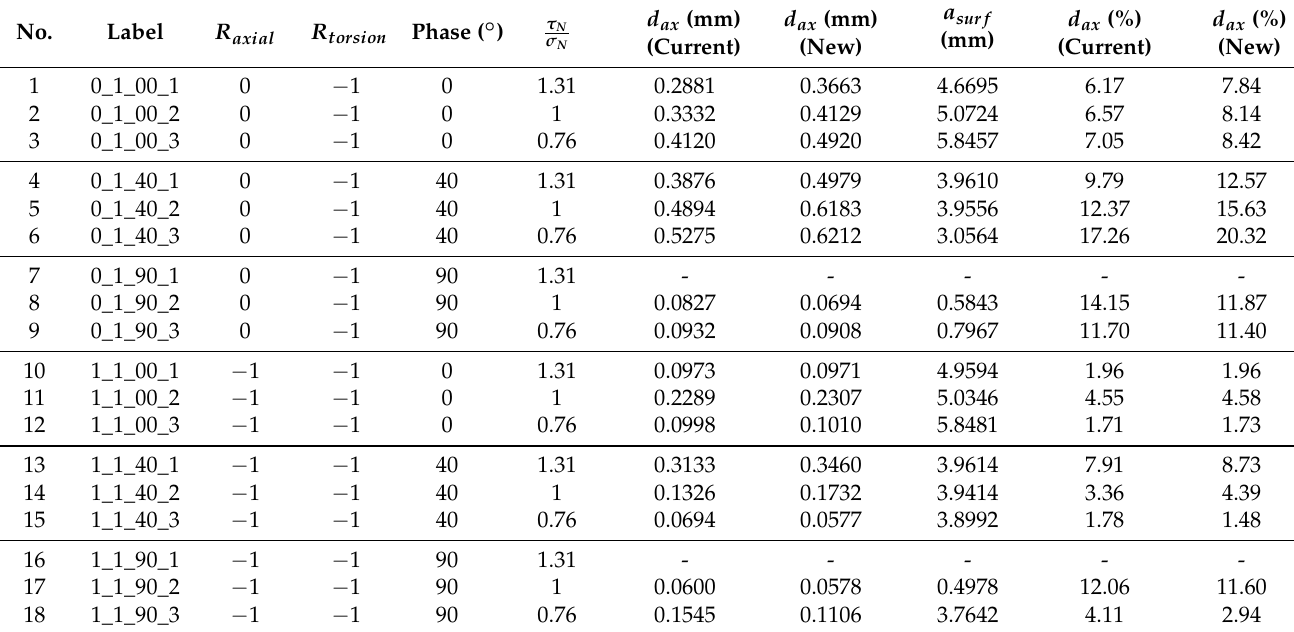
Table 4. Specimens load combinations and deviation results.